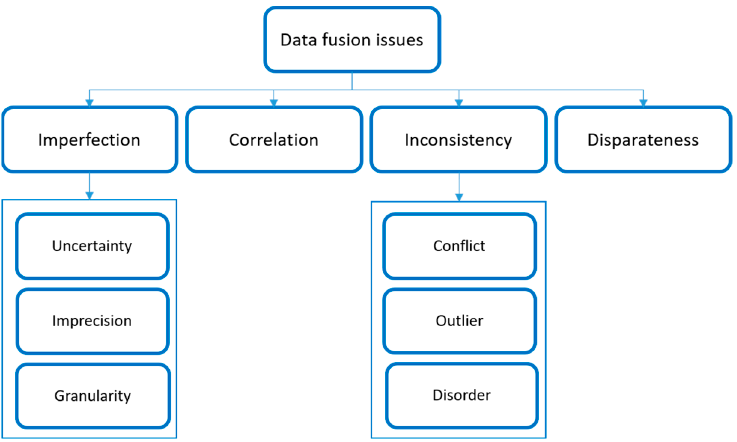
Figure 3. Taxonomy describing data-fusion-related issues.